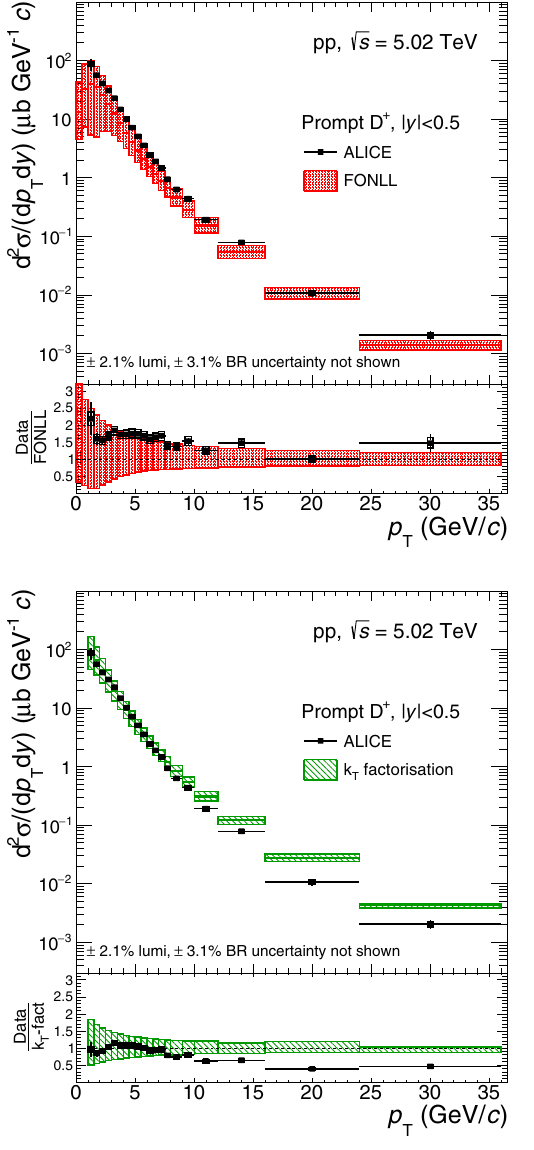
Fig. 9 p T -differential production cross sections for prompt D + meson compared to pQCD calculations: FONLL [7,8], GM-VFNS(mod- μ R , F ) [39,40], GM-VFNS(SACOT- m T ) [6], and k T -factorisation [41]. extraction and cut efficiency were considered as uncorre- lated, while those of the feed-down from beauty-hadron decays and the tracking efficiency were treated as fully cor- related among the different D-meson species. The measured D-meson cross-section ratios do not show a significant p T dependence within the experimental uncertainties, thus sug- gesting no discernible difference between the fragmenta- tion functions of charm quarks to pseudoscalar (D 0 , D + , ) and vector (D ∗+ ) mesons and to strange and non- and D + s strange mesons. The results are compatible within uncer-